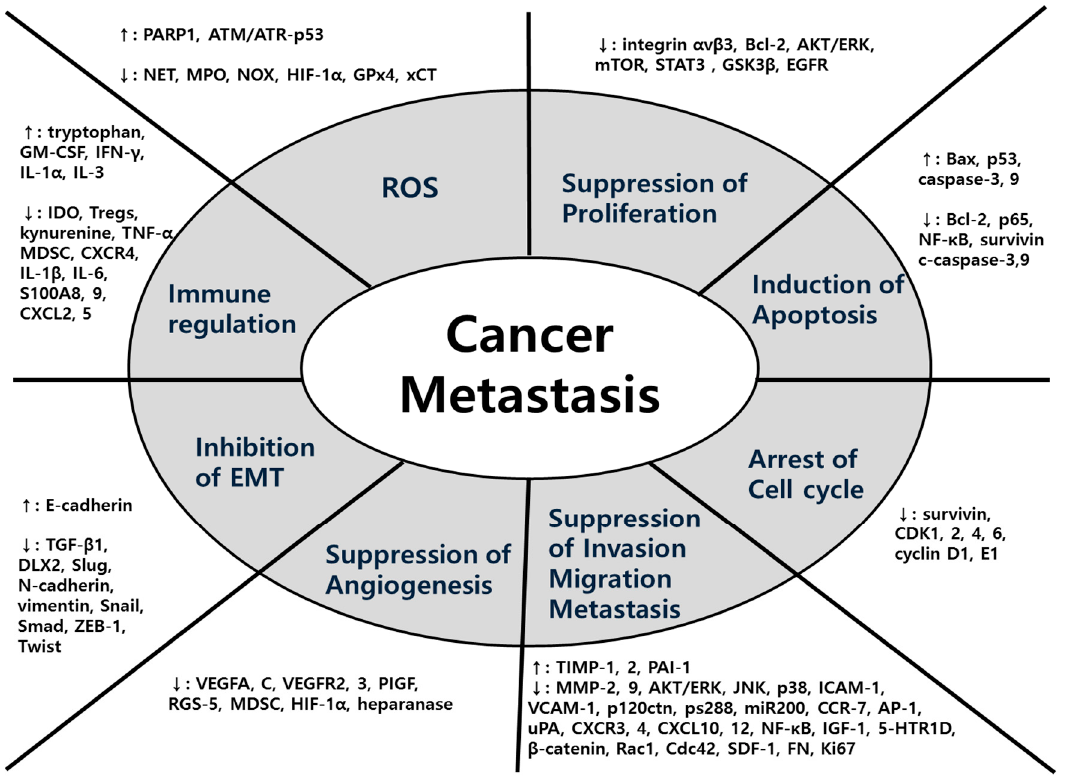
Figure 7. Comprehensive diagram of anti-metastatic factors regulated by herbal medicine: Herbal medicine have diverse efficacies and mechanisms against cancer metastasis. This figure shows the comprehensive view of efficacies and each specific targeting molecules.